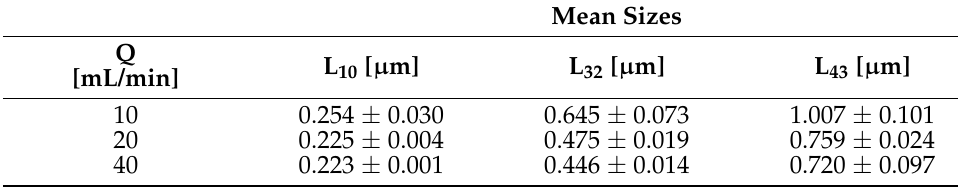
Table 4. Mean sizes depending on the substrate flow velocity.